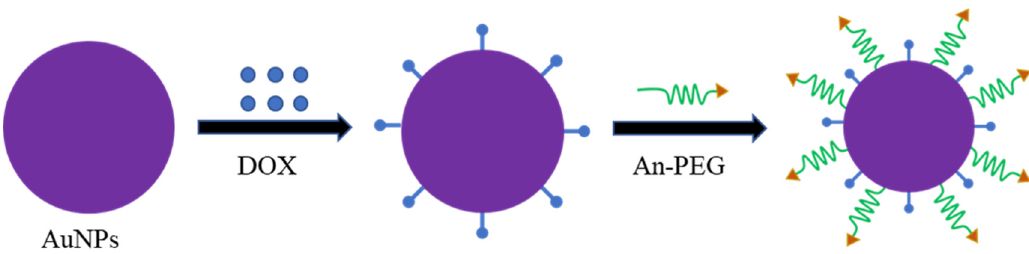
Figure 5. An-PEG modified gold nanoparticles are used to deliver DOX. Abbreviations: DOX, doxorubicin; An, Angiopep-2.